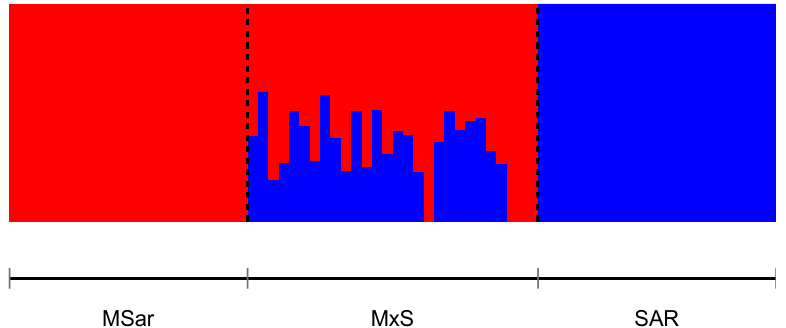
Figure 4. Supervised Admixture plot of MxS dataset obtained using the full set of SNPs. MSar and SAR were used as prior populations.